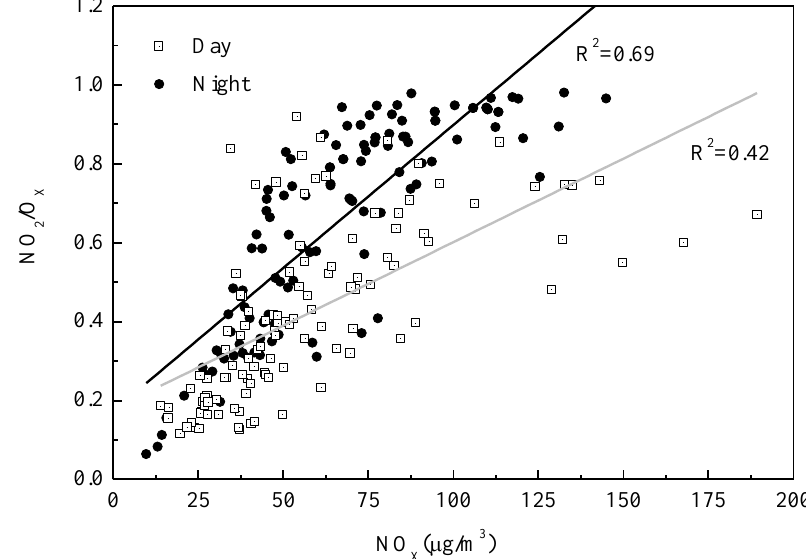
]/[O ] as a function of NO 2 X